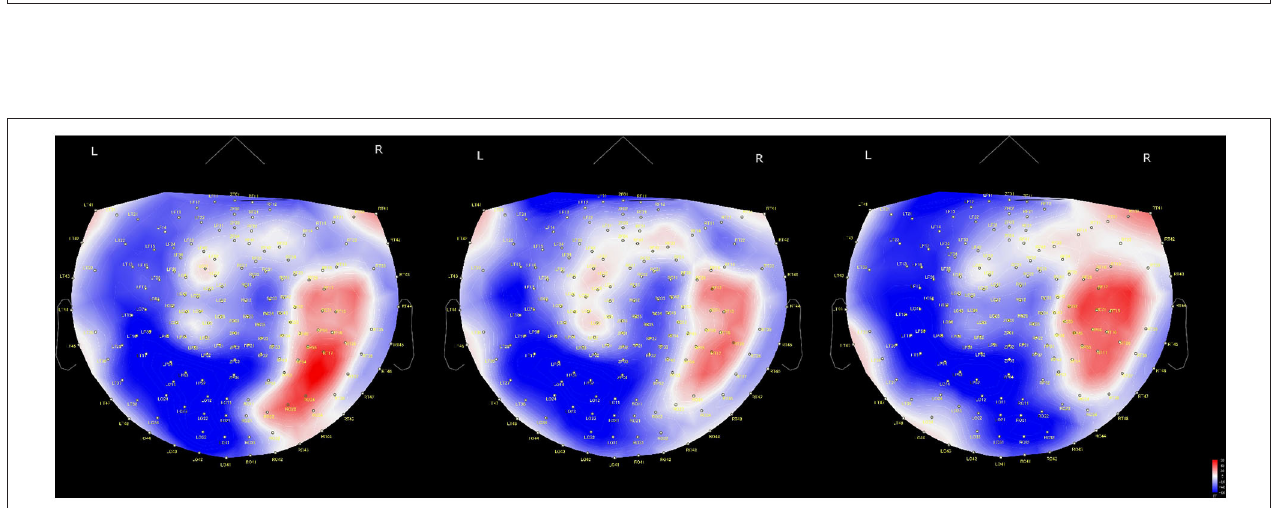
FIGURE 4 | Time-dependent changes in activated brain areas on 2D cap images. Time windows: left shows 62–140ms, middle shows 122–180ms and right shows 182–304ms. L, left hemisphere; R, right hemisphere. The color bar denotes amplitude (fT) from –60 (blue) to 60 (red).